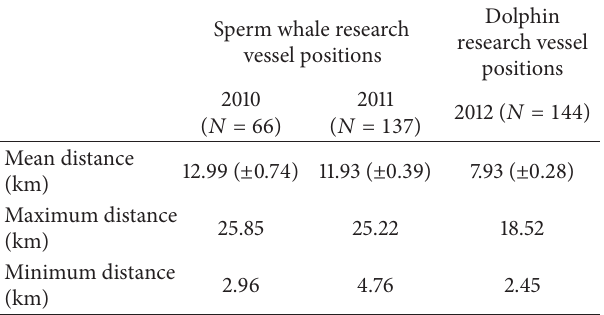
Figure 3: Comparison of all research vessel positions over all years recorded by theodolite (red dots) and by onboard GPS (black dots). Table 1: Distance summary of the two research vessels from the theodolite station ( ± SE).